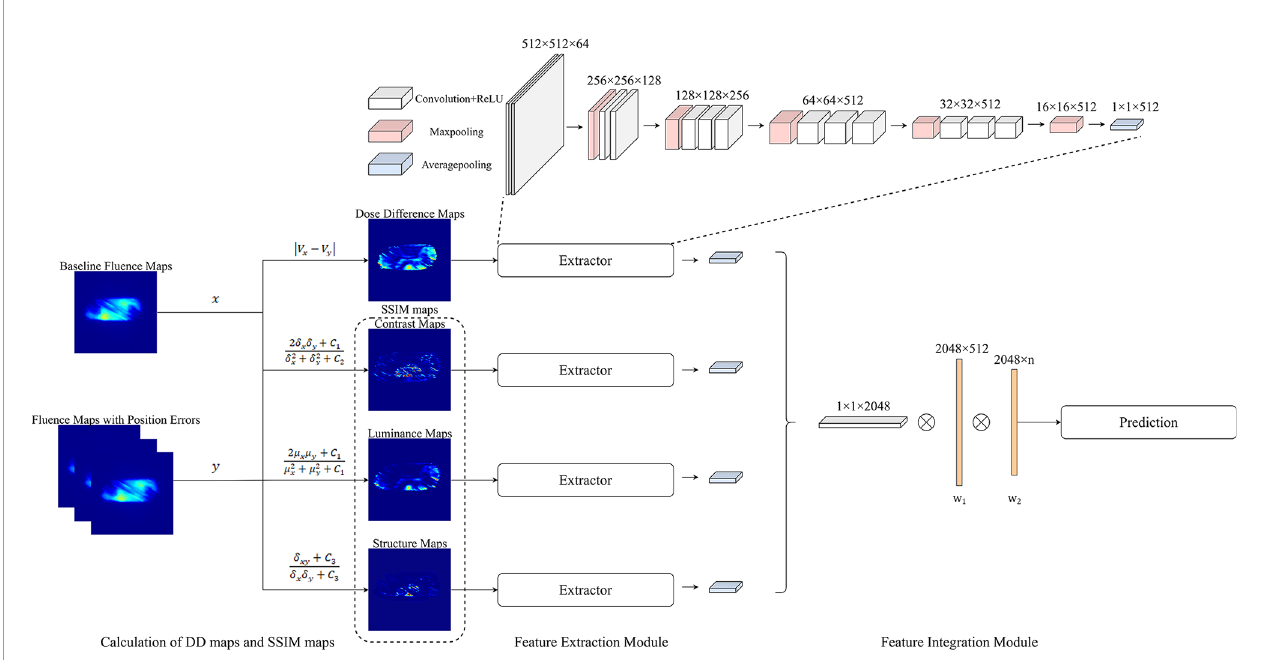
FIGURE 5 | Overview of the process of quantifying the changes in EPID fl uence maps and the structure of CNN. The maps with errors are compared with baseline maps to calculate DD maps and SSIM maps. The overall network comprises feature extraction and feature integration modules. Each feature extractor module comprises 13 convolutional layers, four max pooling layers, and one average pooling layer; the feature integration modules comprise two fully connected layers.